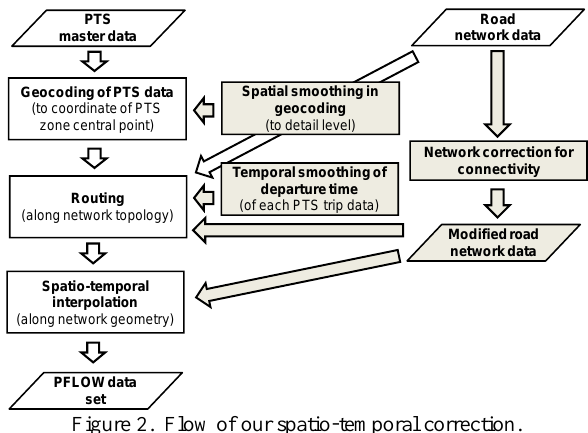
Figure 2. Flow of our spatio-temporal correction.